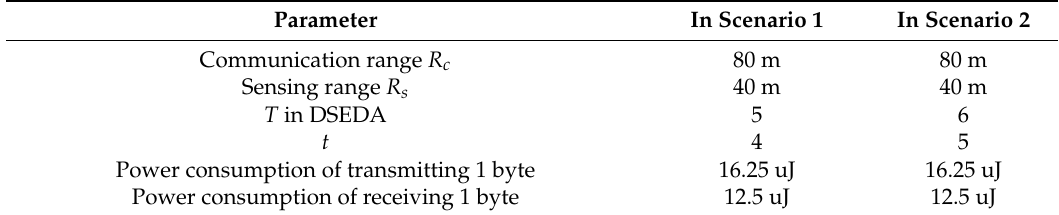
Table 3. Simulation parameters.